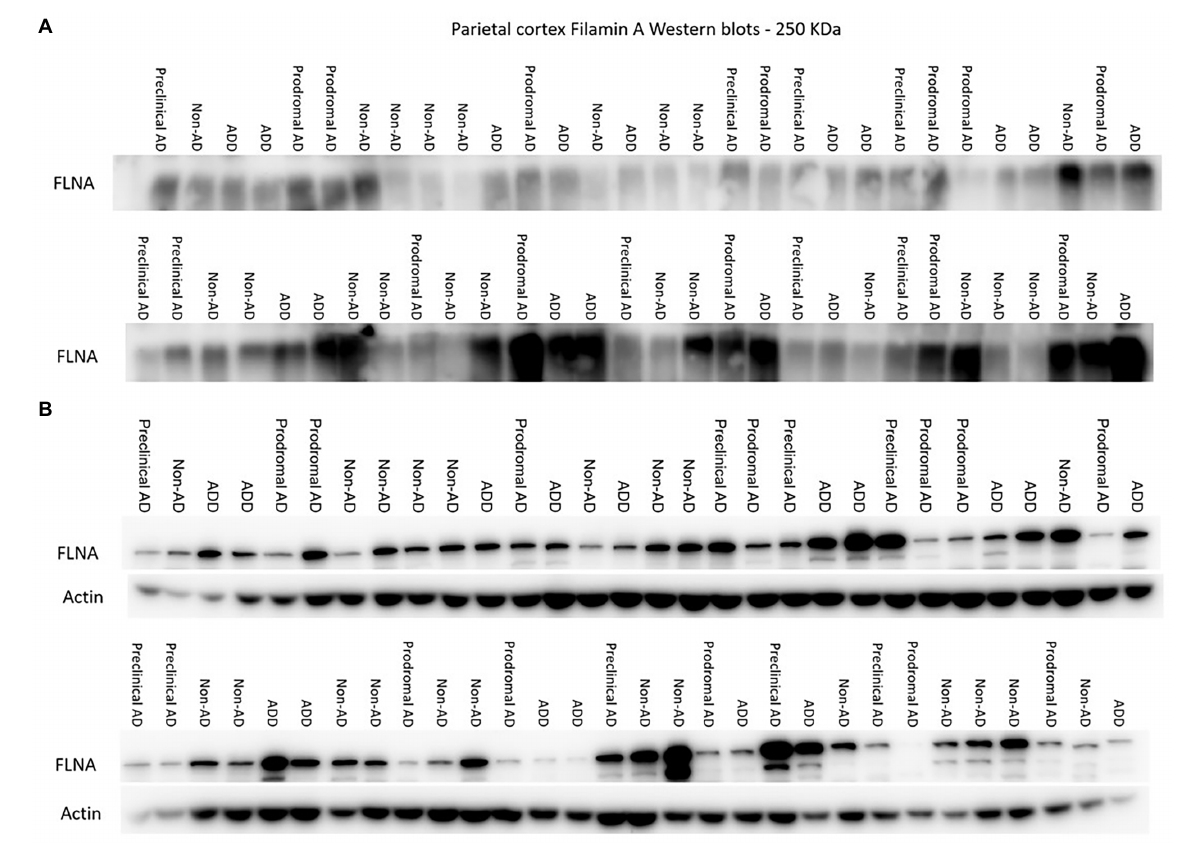
FIGURE 1 Western immunoblotting of insoluble (A) and TBS-soluble (B) Filamin A (FLNA) migrating at approximately 250 kDa. Actin (42 kDa) is shown in soluble fractions. Subjects are identified by group. ADD, AD